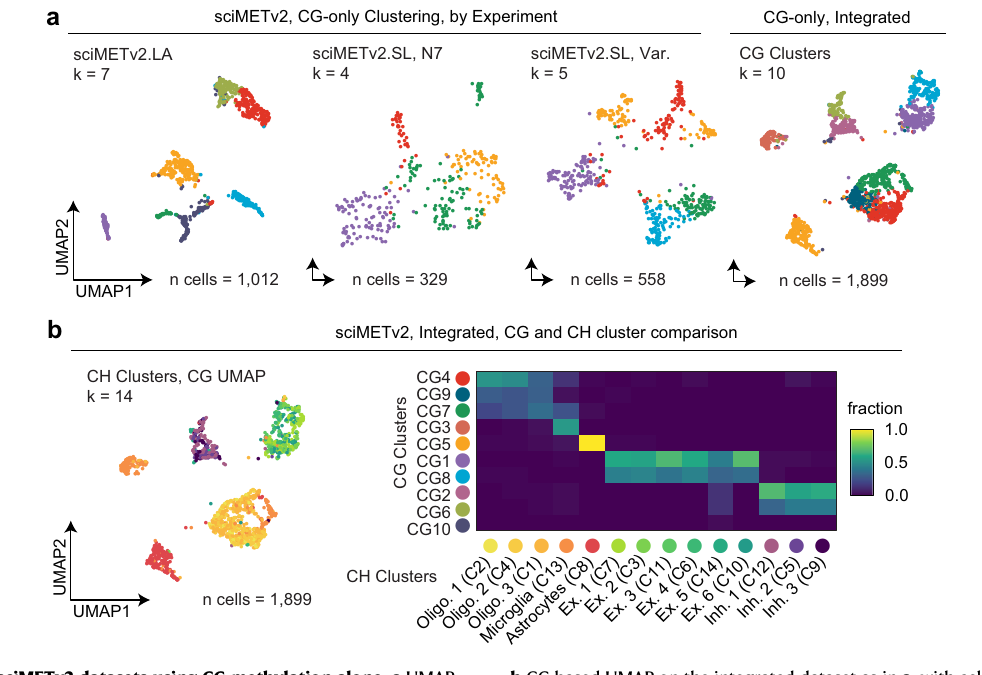
b CG based UMAP on the integrated dataset as in a , with cells colored by CH methylation clusters that were previously determined and a confusion matrix comparing the CG (y-axis) and CH ( x -axis) cluster